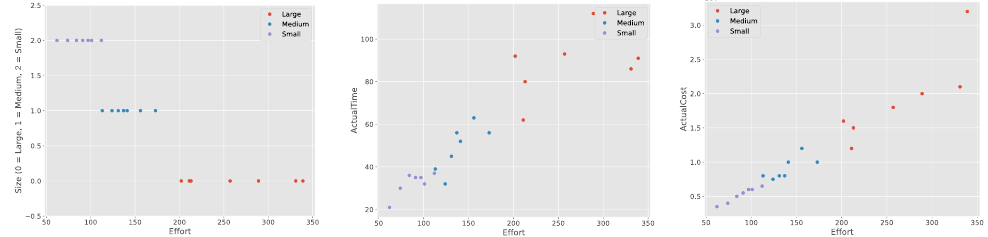
Figure 7. Agile software projects are classified into three groups: small (purple), medium (blue) and large (red). From left to right, we have effort size groups, time size groups and cost size groups.